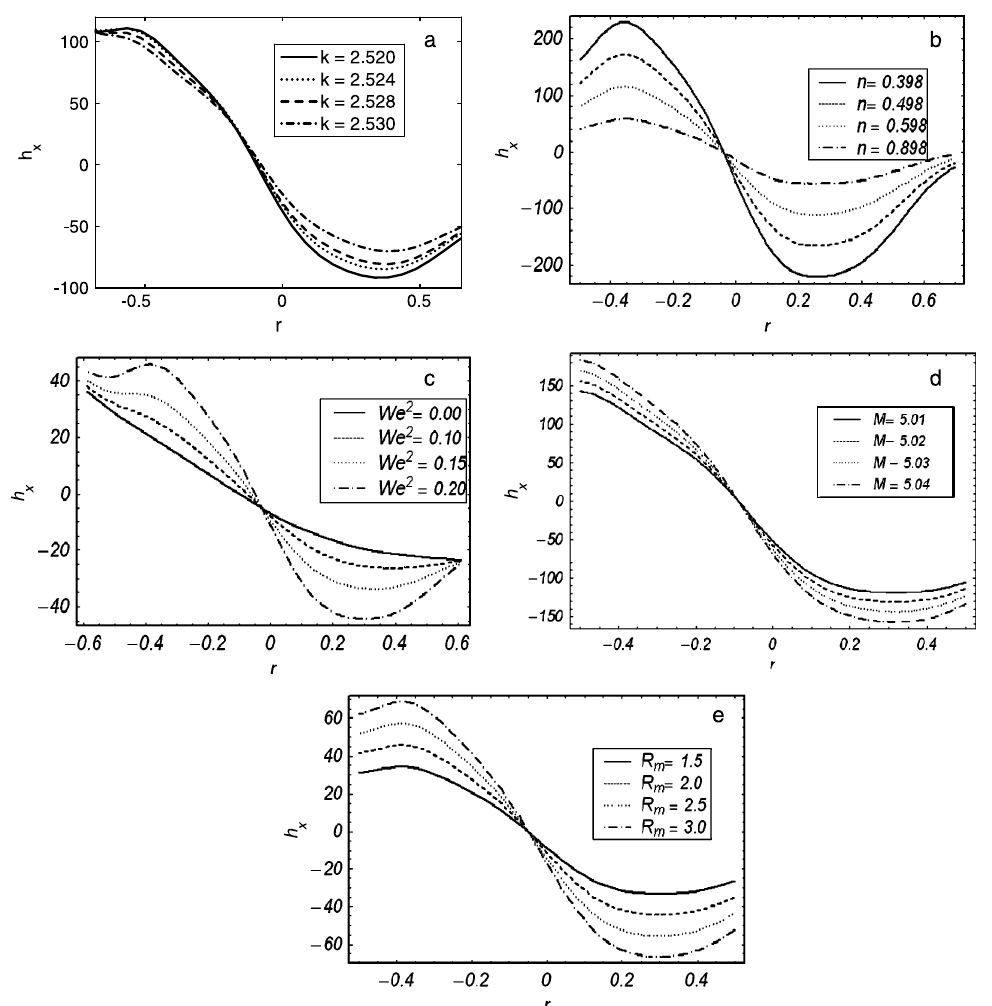
Fig. 5. (a) The axial induced magnetic field h x versus r for α = 0 . 2, θ = 5 ,E = − 3 ,x = − 0 . 2 ,n = 0 . 898 ,We = 0 . 3 ,R m = 4 and M = 5. (b) The axial induced magnetic field h x versus r for α = 0 . 3, θ = − 0 . 2 ,E = − 1 ,x = − 0 . 2 ,k = 2 . 5 ,We = 0 . 5 ,R m = 2 and M = 6 . 25. (c) The axial induced magnetic field h x versus r for α = 0 . 3, θ = − 0 . 6 ,E = − 1 ,x = − 0 . 2 ,k = 2 . 5 ,n = 0 . 9 ,R m = 2 and M = 6 . 25. (d) The axial induced magnetic field h x versus r for α = 0 . 2, θ = 5 ,E = − 3 ,x = − 0 . 2 ,k = 2 . 5 ,n = 0 . 898 ,R m = 4 and We = 0 . 3. (e)The axial induced magnetic field h x versus r for α = 0 . 3, θ = − 0 . 6 ,E = − 1 ,x = − 0 . 2 ,k = 2 . 5 ,n = 0 . 9 ,M = 6 . 25 and We = 0 .